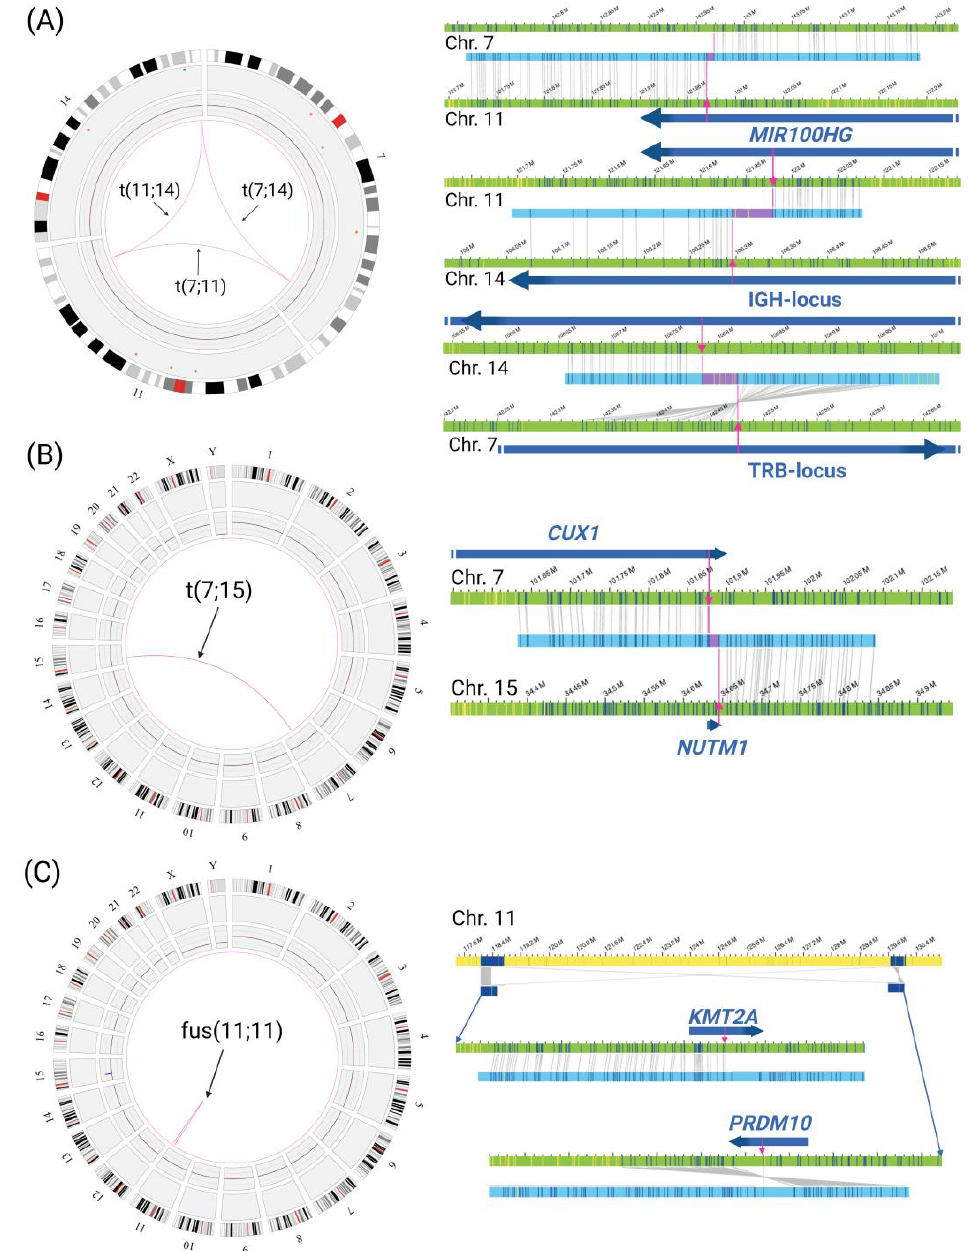
Figure 2. OGM detects rare or new gene fusions: Circos plots and respective SVs representing the gene fusions. Orientation of genes is indicated by arrows. ( A ) Three-way translocation involving the IGH locus on chromosome 14q, TRB locus on 7q, and MIR100HG micro-RNA on chromosome 11 (patient 5). ( B ) Circos plot and interchromosomal translocation SV reveal a t(7;15)(q22.1;q14) and the resulting CUX1::NUTM1 fusion breakpoint region (patient 7). ( C ) Circos plot and intrachromosomal fusion SV showing KMT2A fused to PRDM10 in patient 10. Created with